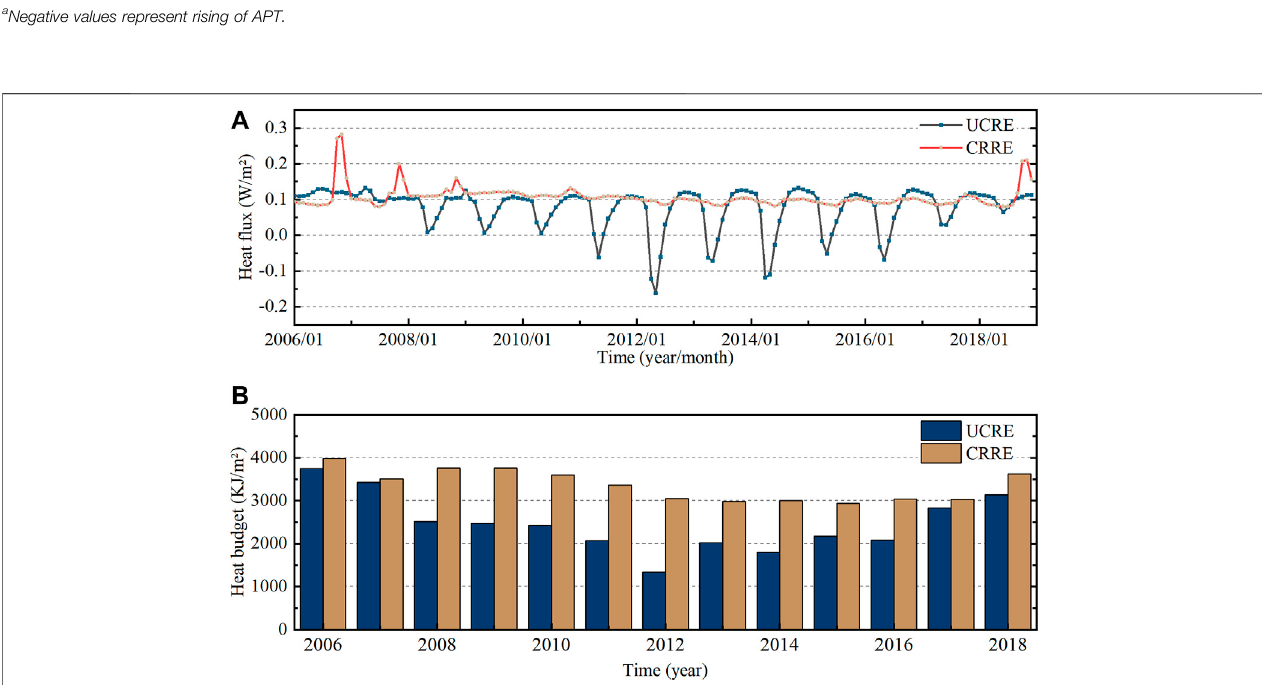
Frontiers in Earth Science |